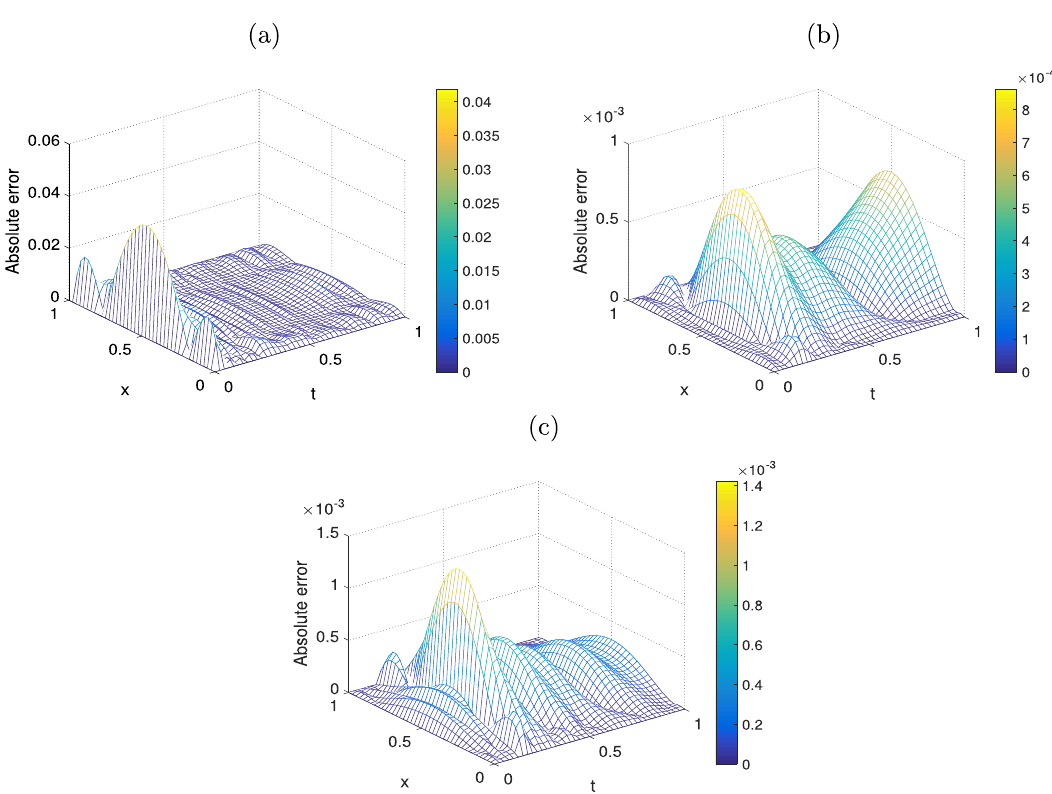
Figure 6: The errors between the exact ( 78 ) and approximate ( ) u x t , with λ : ( a ) 0, ( b ) 10 −8 and ( c ) 10 −7 , with = p 1% , for Example